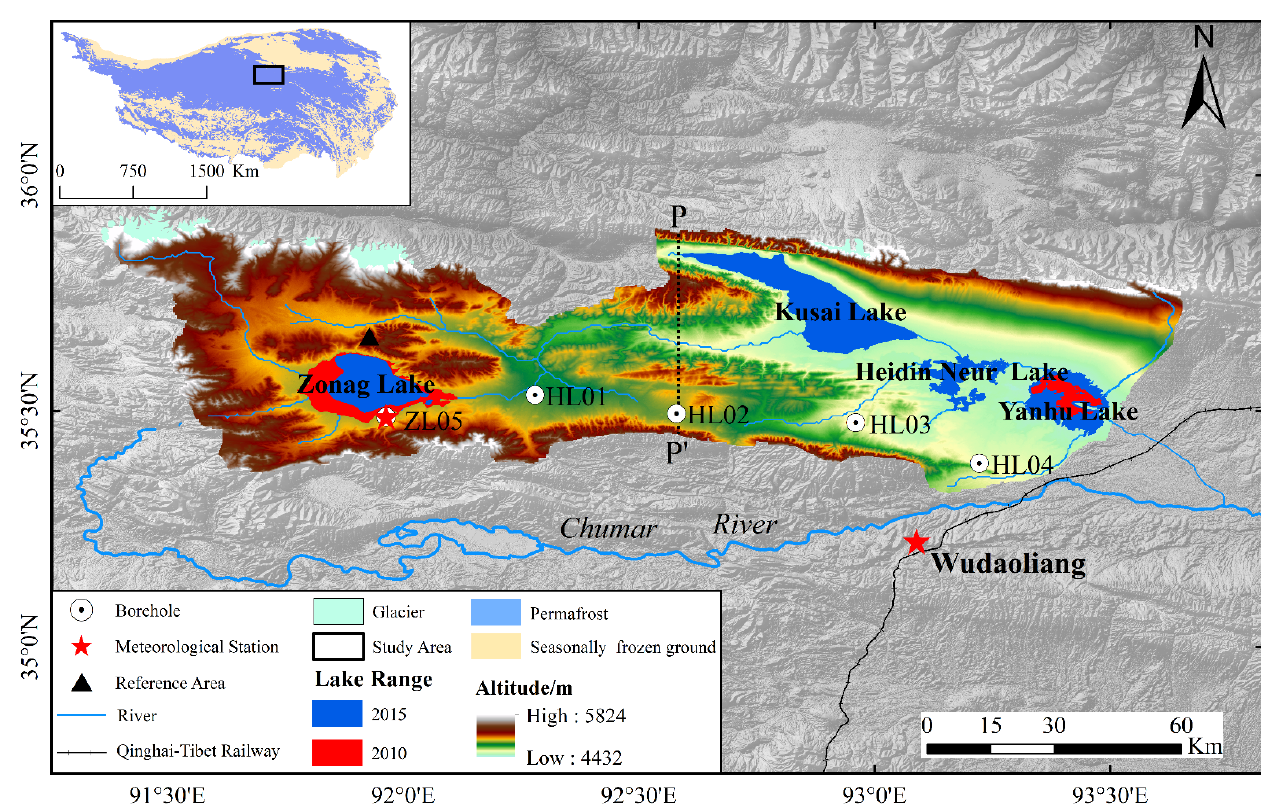
Figure 1. Study area. The background is the hillshade of terrain. The black box in the upper left corner of the figure indicates the location of the study area on the QTP. The black triangle represents the reference point of SBAS-InSAR observation. The black dotted lines (P-P’) are the random profiles used to analyze the relationship between SDA and time characteristics of the F-T